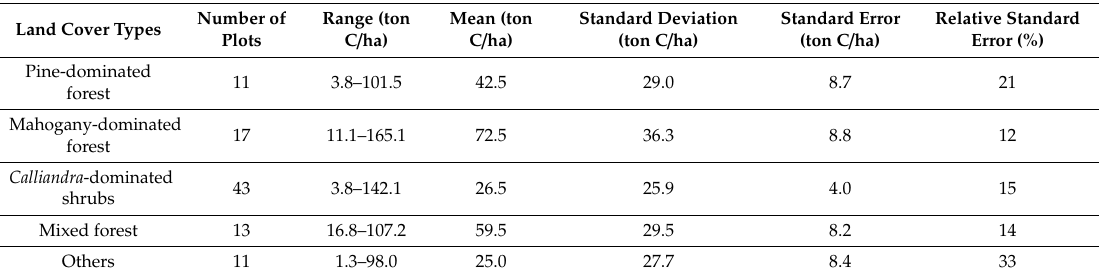
Table 2. Range, mean, and standard deviation of aboveground carbon in di ff erent land cover types in the Geulis Mountain forest.